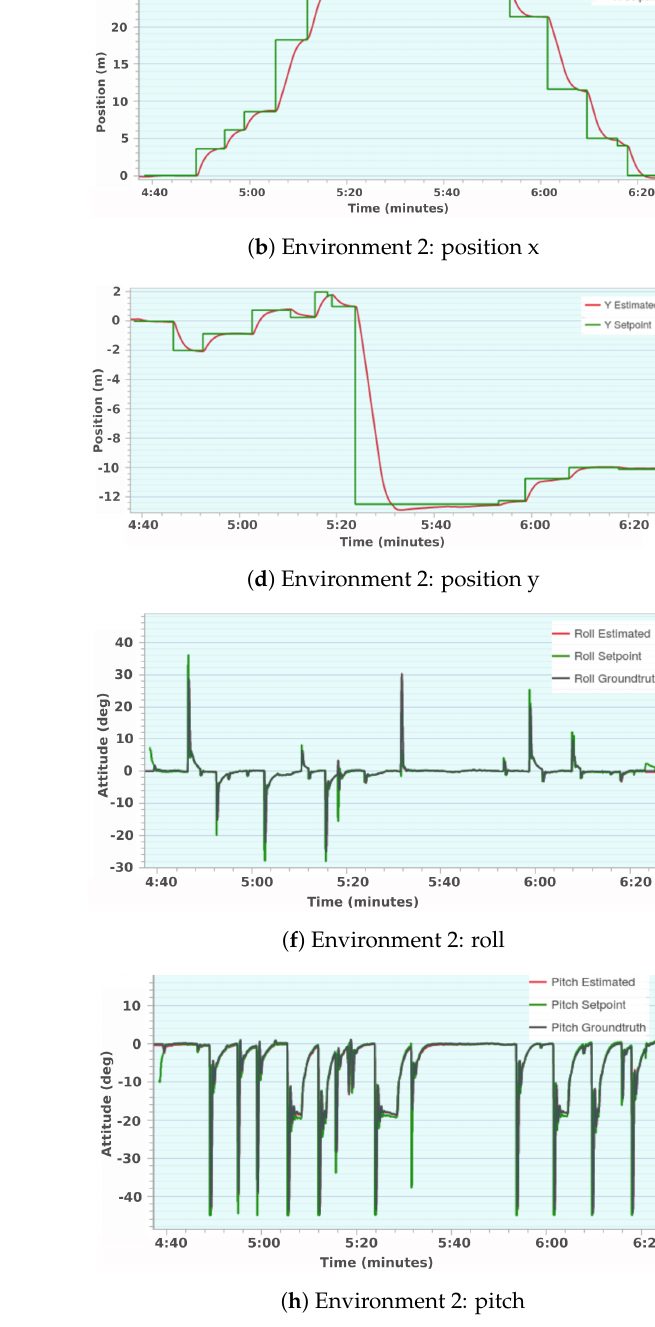
Figure 10. Simulation: position and attitude accuracy